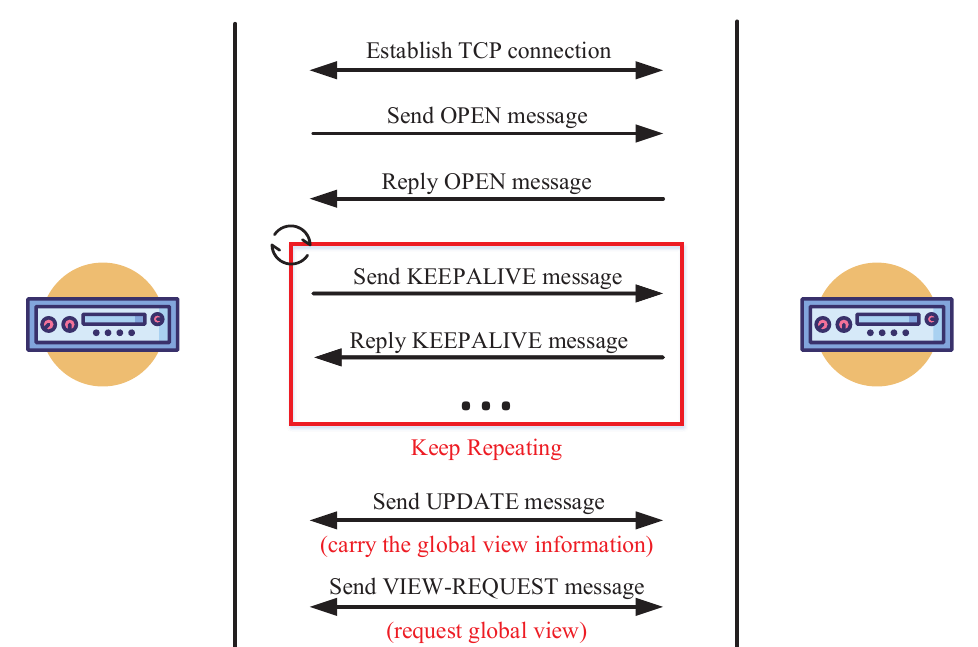
Figure 2. Global view exchange mechanism. SDN controllers exchange messages between them to achieve the effects of east–west connectivity, view updates, view requests, etc., and constantly communicate with each other to keep the global view up to